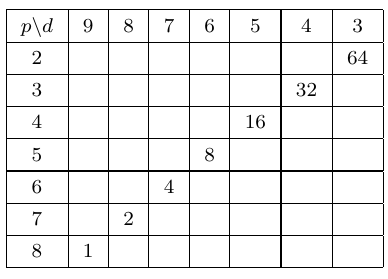
Table 29 . Number of E (4;0) -branes in the p -brane multiplet in d -dimensions [13]. p \ d